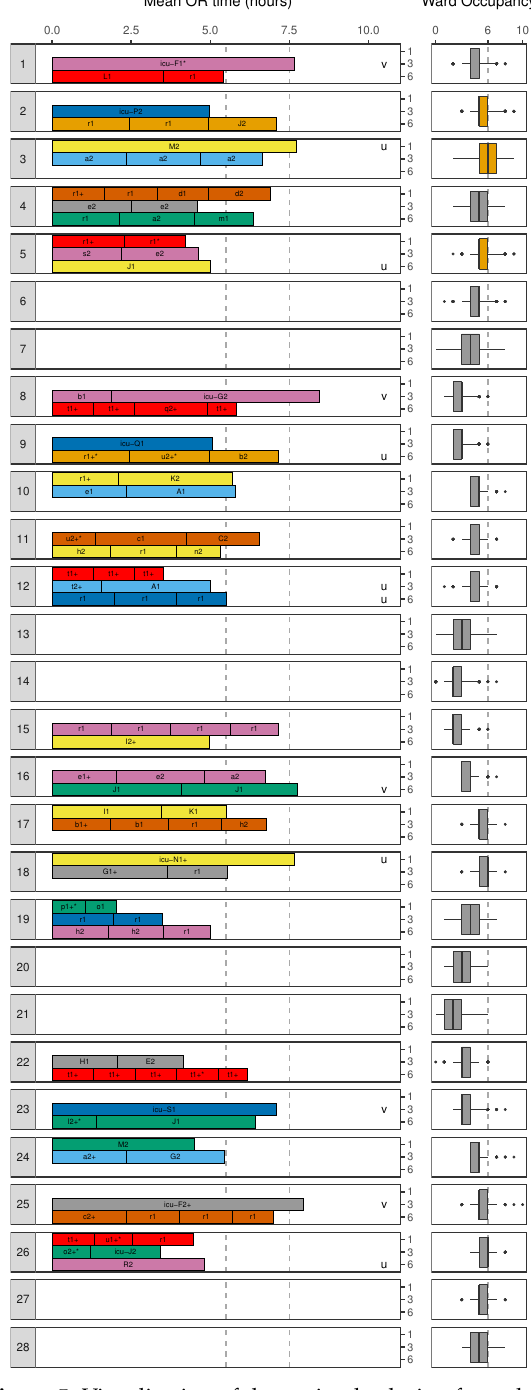
Figure 5. Visualisation of the optimal solution from the robust ward optimization (RWO) for each day and OR (1, 3 and 6) and the corresponding ward occupancy (for the ward occupancy, the color is yellow if there is risk of overflow and is grey if not. The dashed line represent the maximum number of staffed ward beds ( M A )). Colors reflect the operators, and the text is the code of the surgical procedure (if the surgical procedure code is in upper case, ward admission is required. The symbol + denotes if a patient arrived during the execution of the schedule, ∗ denotes one-week priority and ICU denotes if ICU is required. The dashed lines represent the opening hours of the ORs ( C d , r )). The tags u and v denote if the threshold for the risk of regular or extended overtime is surpassed,